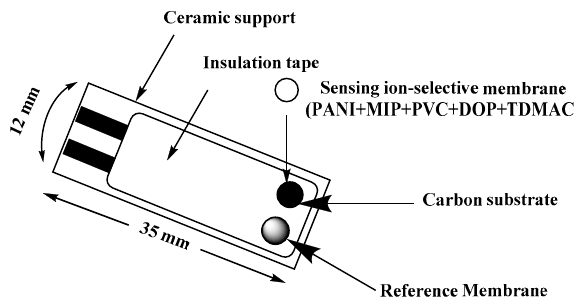
Figure 1. Schematic representation of screen printed planar electrode.